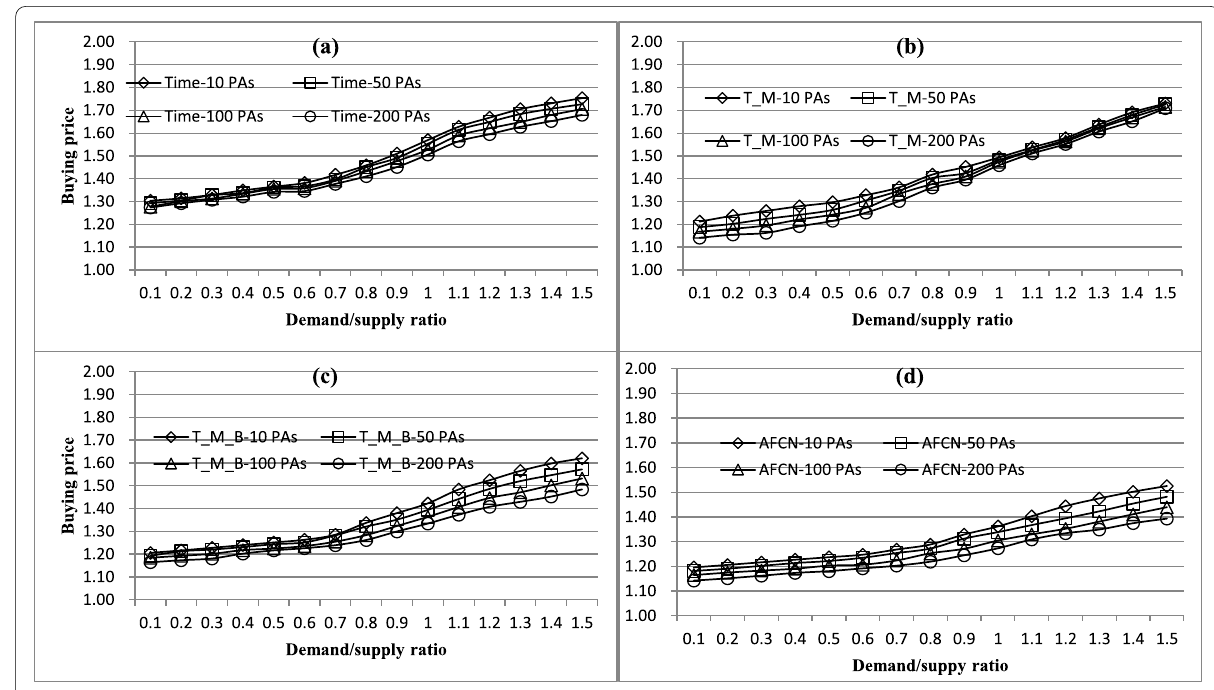
Fig. 15 Buying price for different numbers of